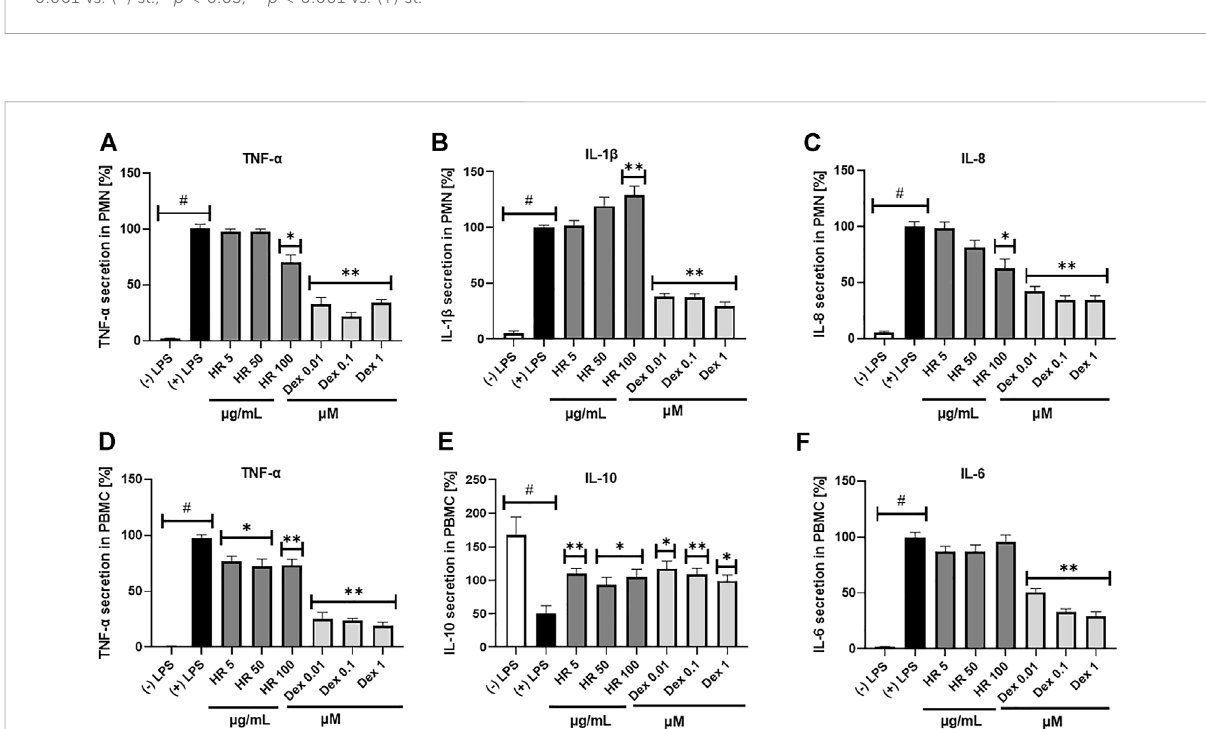
FIGURE 3 Effect of HR on secretion of cytokines (mean ± SEM [%]) by PMN (A – C) and PBMC (D – F) . HR — aqueous extract from the fruit of Hipopphaë rhamnoides ; Dex — dexamethasone. # p < 0.001 vs. ( − ) LPS; * p < 0.05, ** p < 0.001 vs. (+)